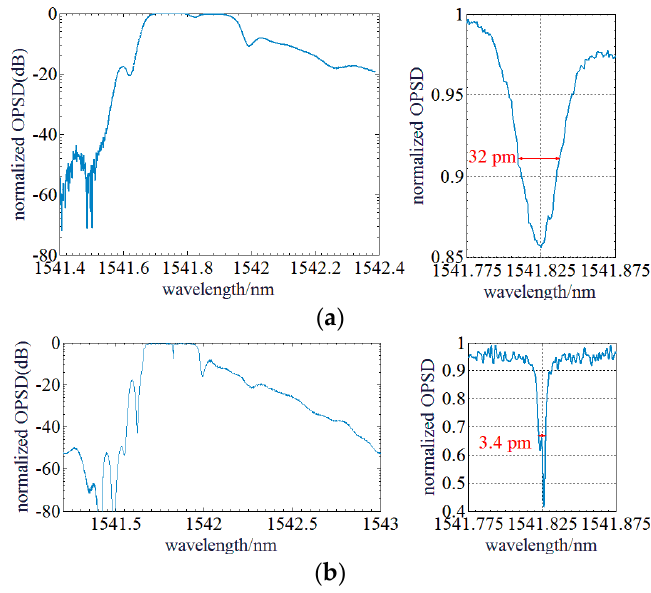
Figure 12. ( a ) Optical spectrum of the PS-FBG sensor measured by an Anritsu OSA. ( b ) Optical spectrum of the PS-FBG sensor measured by the OENF system.